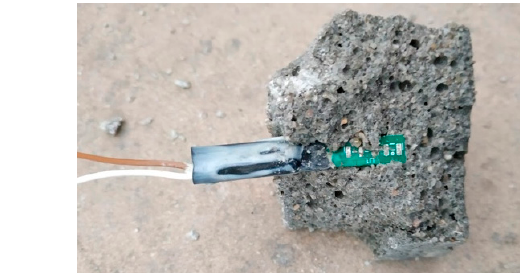
Figure 1. Scheme ( left ) and photography ( right ) of the sensors embedded in the